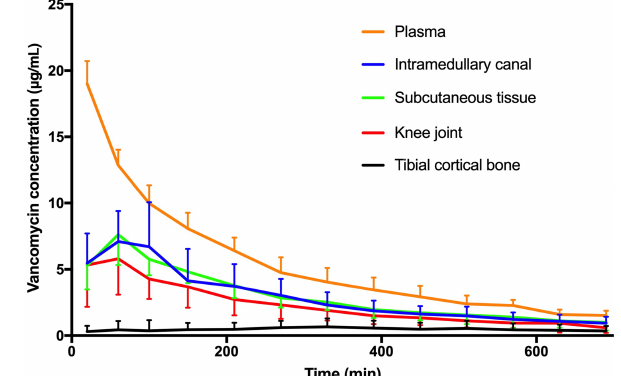
Figure 3. Mean concentration–time profile for plasma, in- tramedullary canal, subcutaneous tissue, synovial fluid of the knee joint, and tibial cortical bone. Bars represent standard deviation.